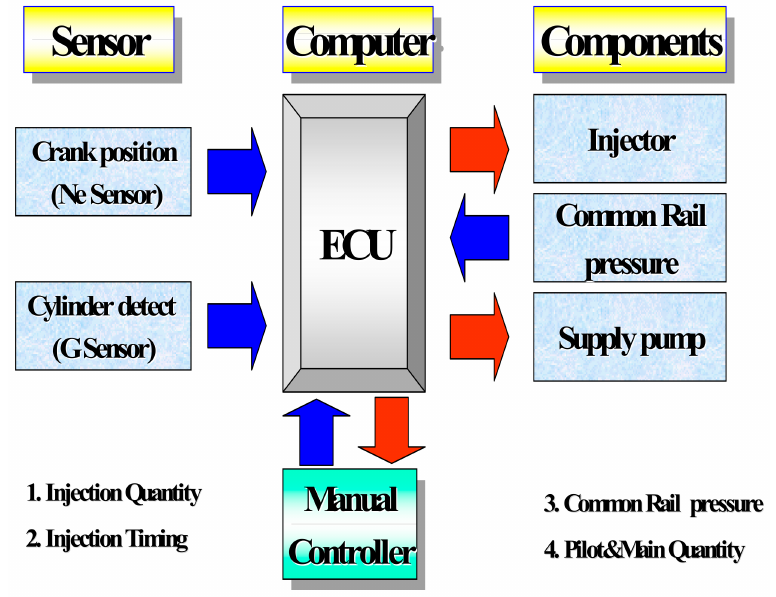
Figure 2. Schematic diagram of control signal